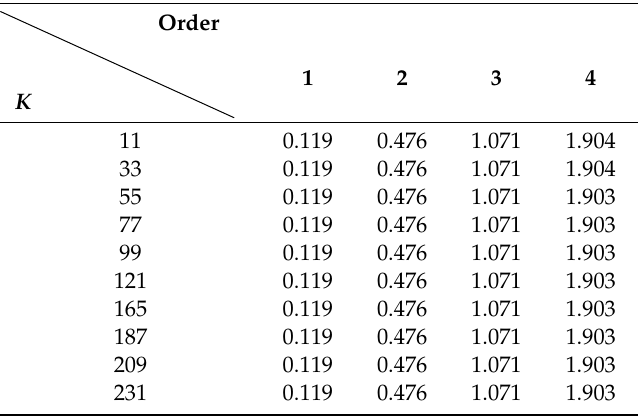
Table 1. Natural frequencies via modal discretization ( h =